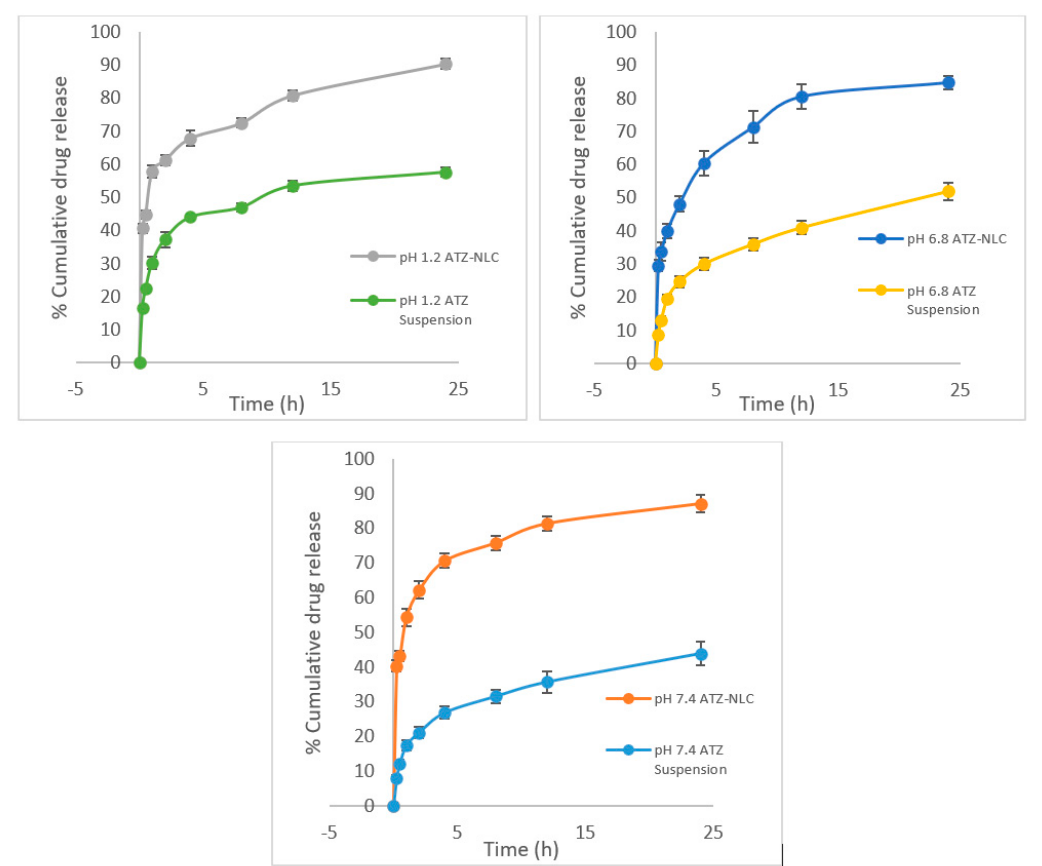
Figure 6. In vitro release profile of ATZ-NLC and ATZ suspension in different buffer media.